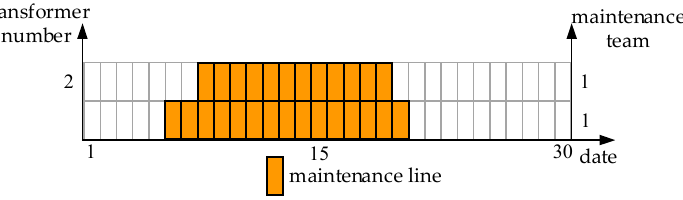
Figure 11. Transformer maintenance scheduling and resource arrangement.